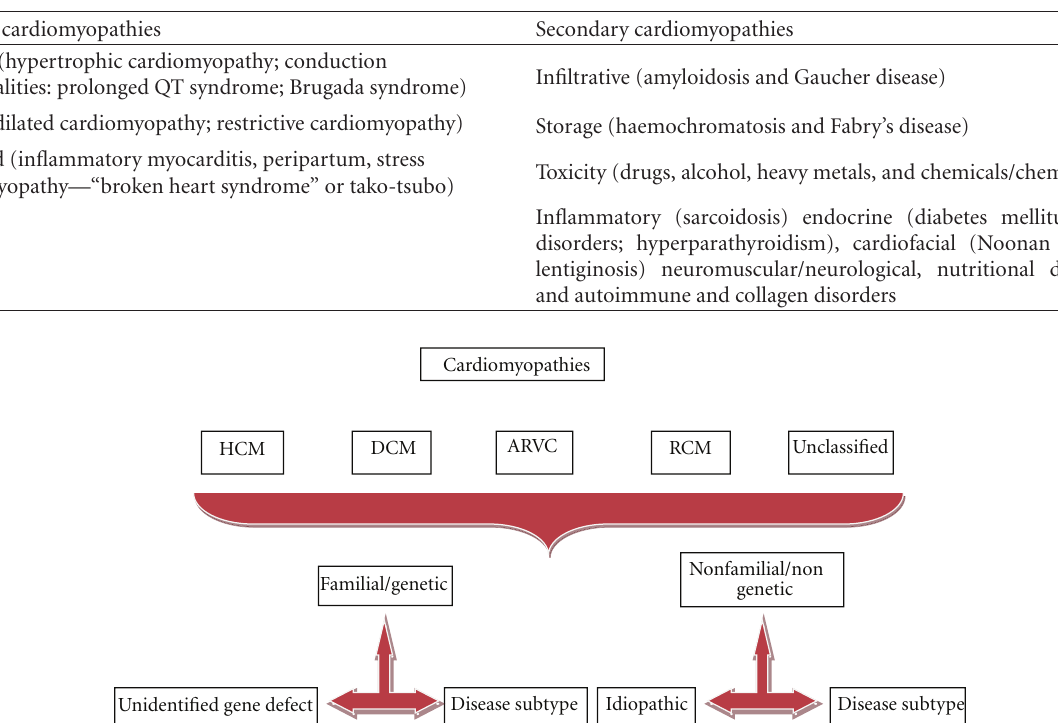
Table 1: Summary of AHA 2006 classification [1].